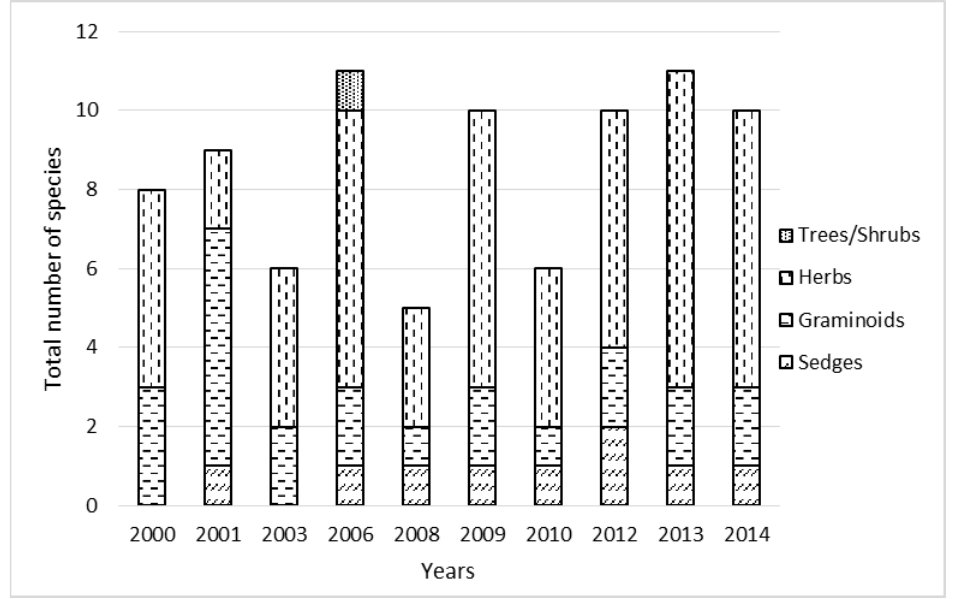
Figure 2. Total number of species according to plant group (trees/shrubs, herbs, graminoids or sedges) in the Västkärr wetland, 2000–2014. Species richness of the herb group tended to increase.